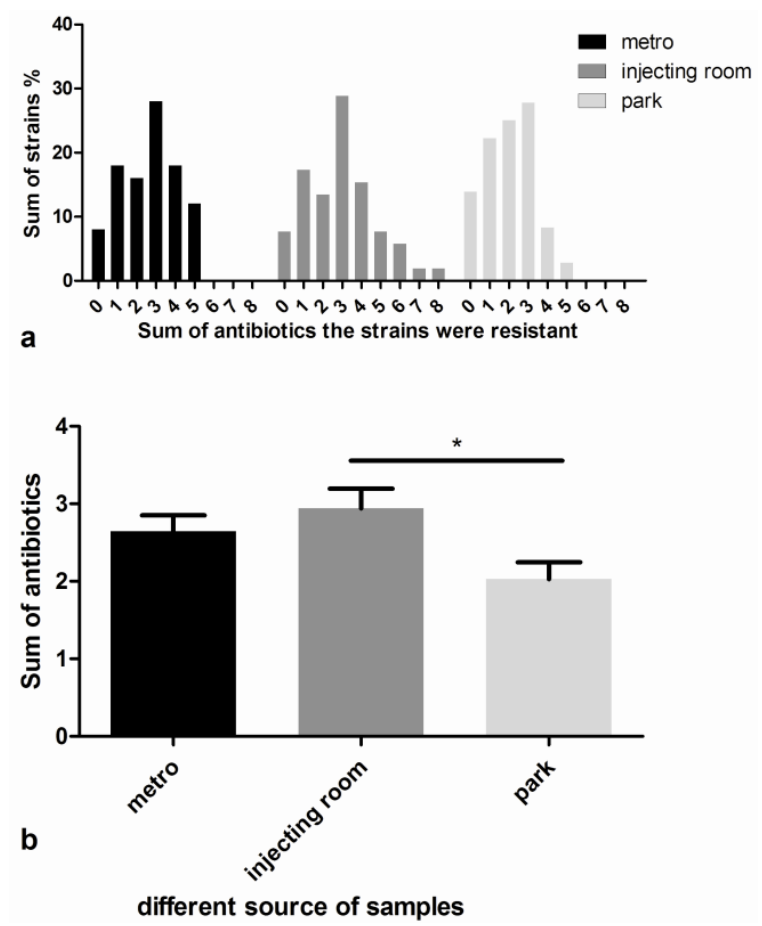
Figure 2. Statistical analysis of antibiotic-resistant strains. ( a ) The distribution of drug-resistant strains. The abscissa represents the number of antibiotics against which the CNS strains were resistant. The ordinates show the ratio of such strains in the total number of samples. The distribution of antibiotic-resistant strains showed a lower frequency of strains with resistance to more than three antibiotics in the park samples compared with those from the metro and hospital; ( b ) Staphylococcus samples from the park were resistant to an average of 2.03 antibiotic types, which was significantly lower (Student’s t- test, p < 0.05) than those from the metro (mean, 2.64) and hospital (mean,